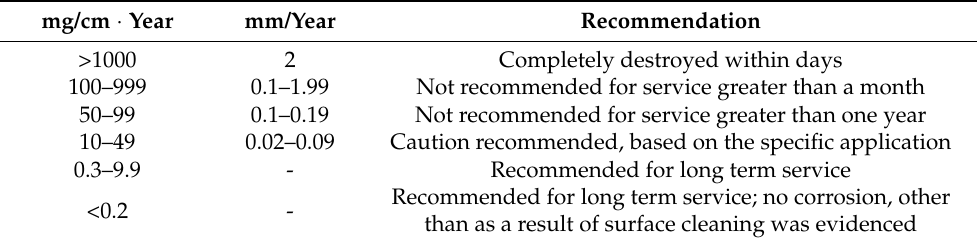
Figure 13. Corrosion rate of aluminum, copper, and carbon steel in the eutectic mixture. Table 4. Guide for corrosion and weight loss in industries [ 19 ].